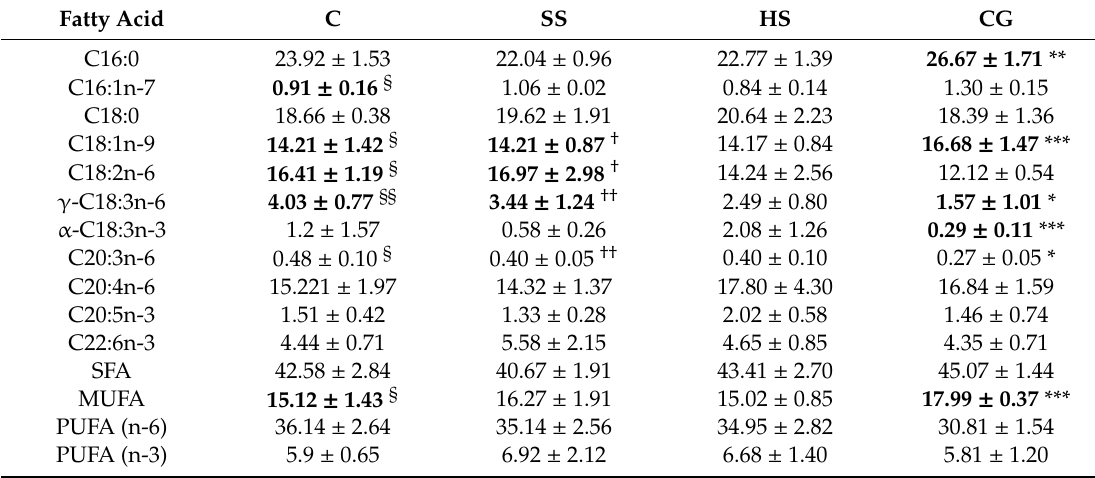
Table 6. Fatty acid composition in the serum of the experimental rat groups.